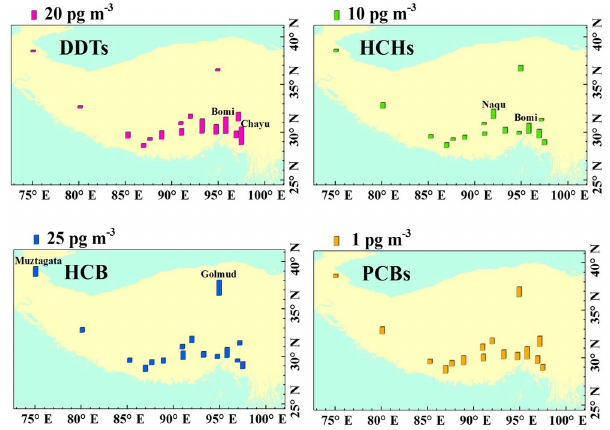
Figure 2. Spatial distribution pattern of DDTs, HCHs, HCB, and PCBs across the Tibetan